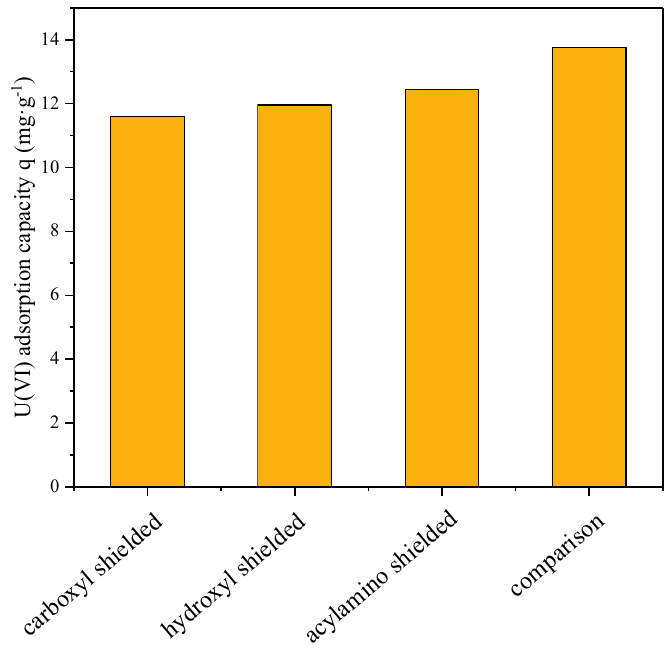
Figure 12. U(VI) adsorption capacity after the functional groups were shielded.